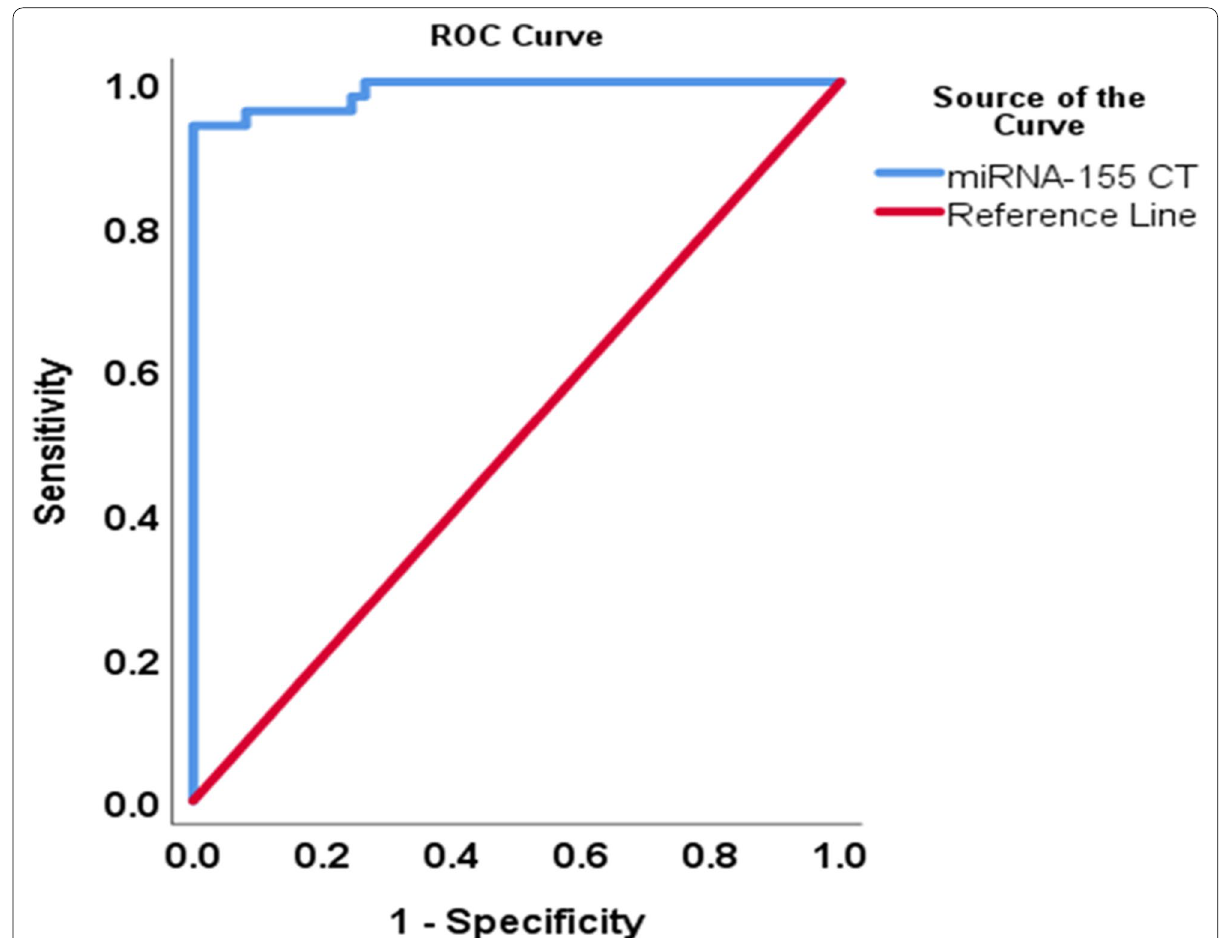
Fig. 4 ROC curve discriminant analysis between periodontal health and disease based on miRNA-155